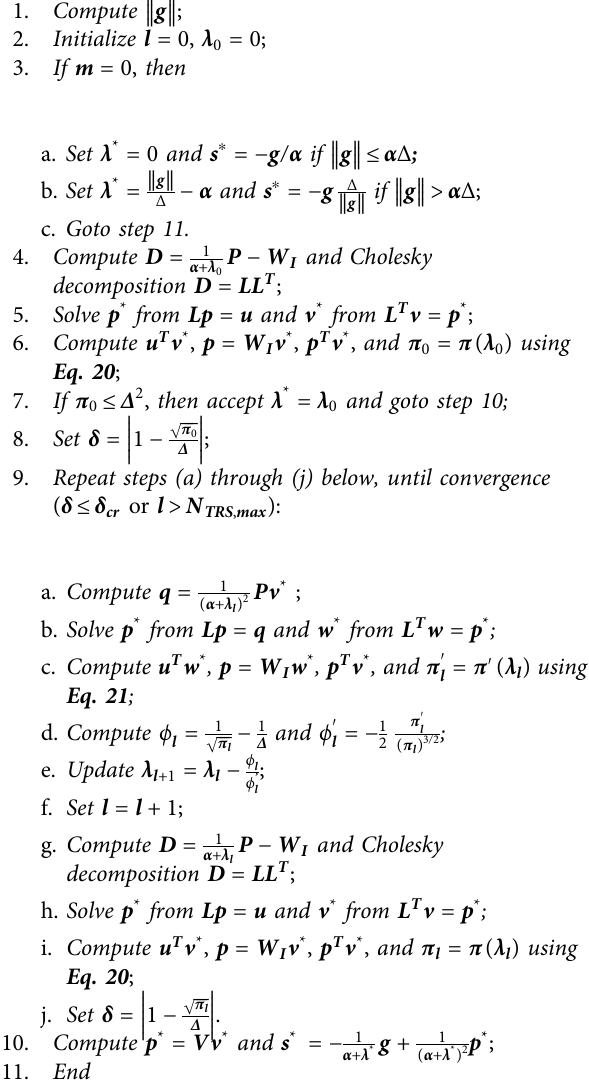
Algorithm-5: Solving the L-BFGS TRS Using the Matrix Inversion